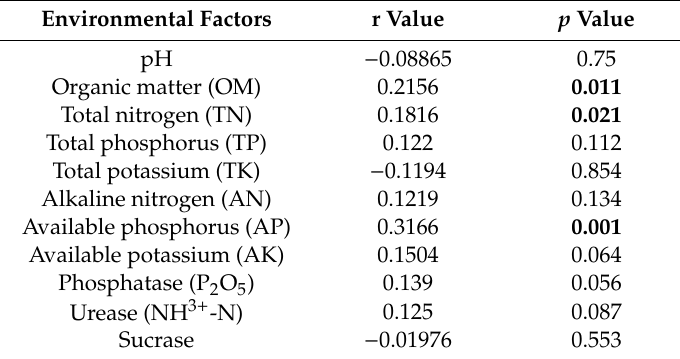
Figure 6. Redundancy analysis (RDA) of the change in the fungal community with environmental variables. ( a ) The relationship between different fertilizer treatments and environmental variables, and ( b ) The correlation between soil environmental variables and fungal community profiles. Table 2. Correlation Analysis of the Soil Fungal Community and Environmental